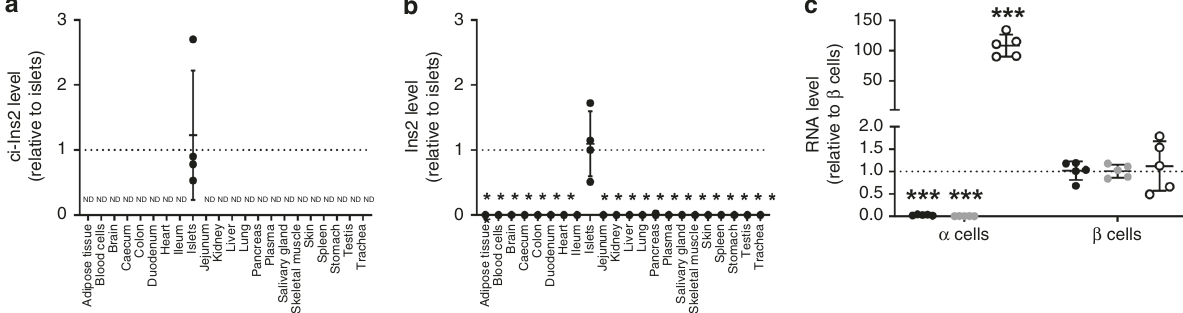
Fig. 3 ci-Ins2 is speci fi cally detected in β cells. a ci-Ins2 and ( b ) Ins2 normalized to Hprt1 , measured by qPCR, in rat blood cells, plasma, and 19 tissues relative to islet levels. ND = not detected. n = 4 independent experiments. * p < 0.0001 vs. islets by one-way ANOVA and Dunnett post hoc test. c ci-Ins2 (black circles), Ins2 (gray circles), and Gcg (clear circles) normalized to Hprt1 , measured by qPCR, in rat α -cells relative to β -cells. n = 5 independent experiments. *** p = 0.000005 (ci-Ins2), *** p = 0.0001 ( Ins2 ), and *** p = 0.0002 ( Gcg ) vs. β -cells by two-tailed unpaired t -test. a – c Data and mean are represented ± s.d. Source data are provided as a Source Data fi